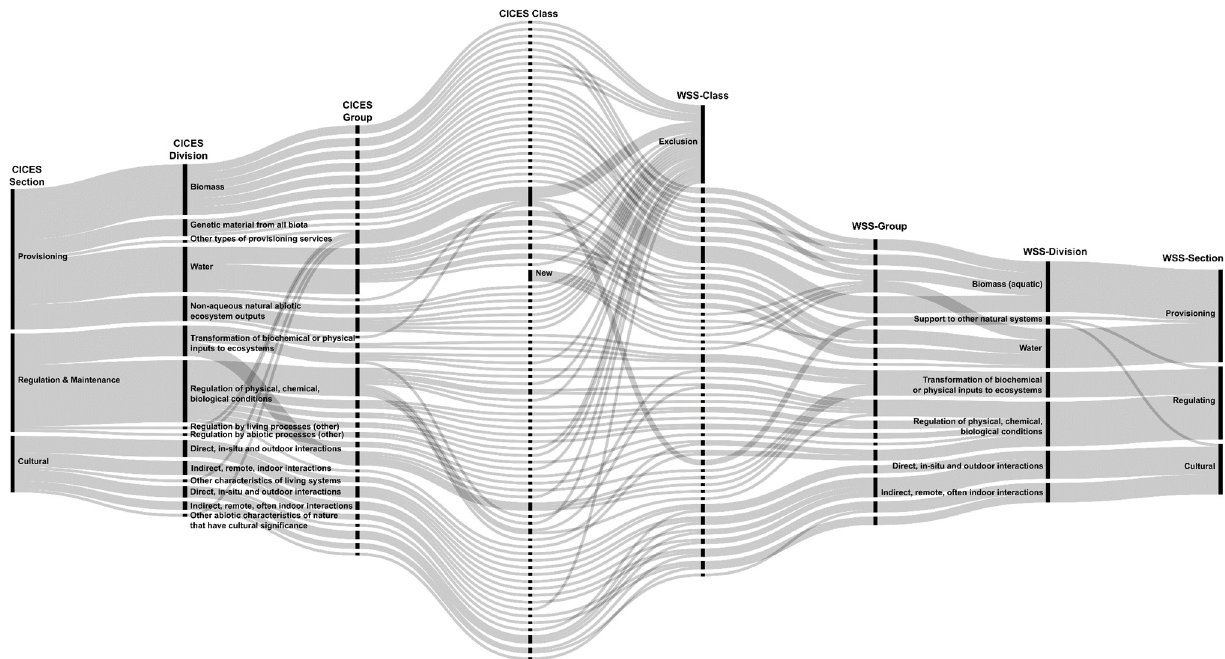
Figure 5. Transformation of the ecosystem service framework CICES v.5.1 into the water system services list. The names of CICES groups, CICES classes, and WSS classes are not displayed to provide better readability. For the same reason, the abiotic and biotic CICES sections have been merged. A detailed description of all classes can be found in Supplementary Material S3.